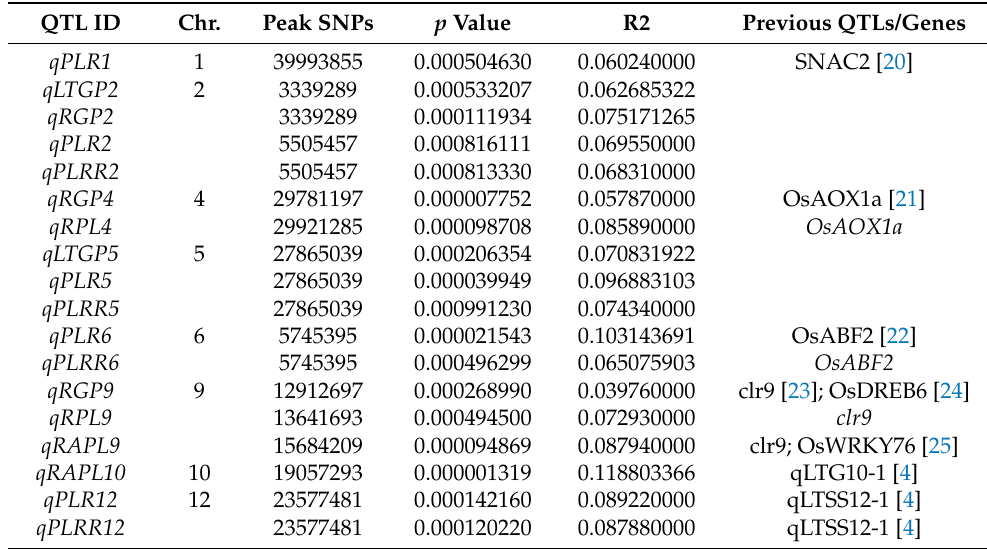
Table 2. Summary of the QTL identified by GWAS mapping for six LTG indices and co-localized genes and